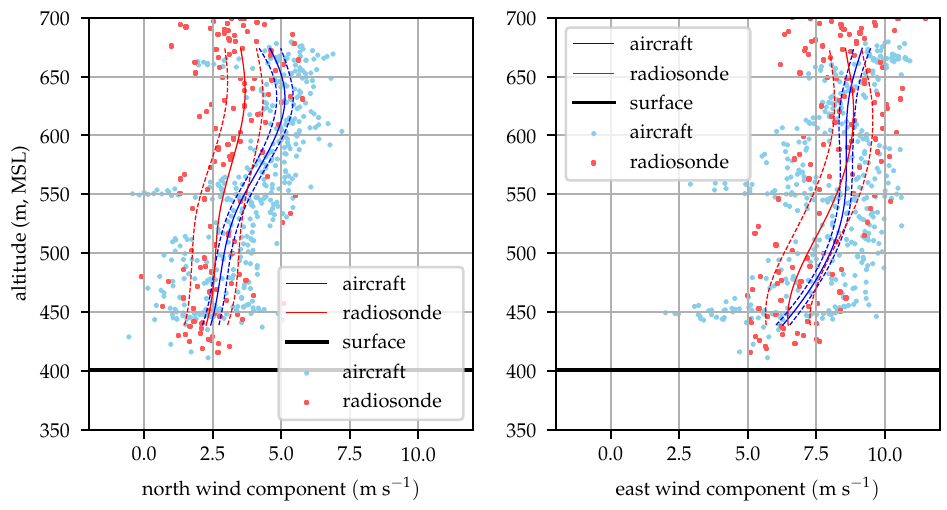
Figure 16. Aircraft and radiosonde profiles from 13:00 local time (2018-12-06).